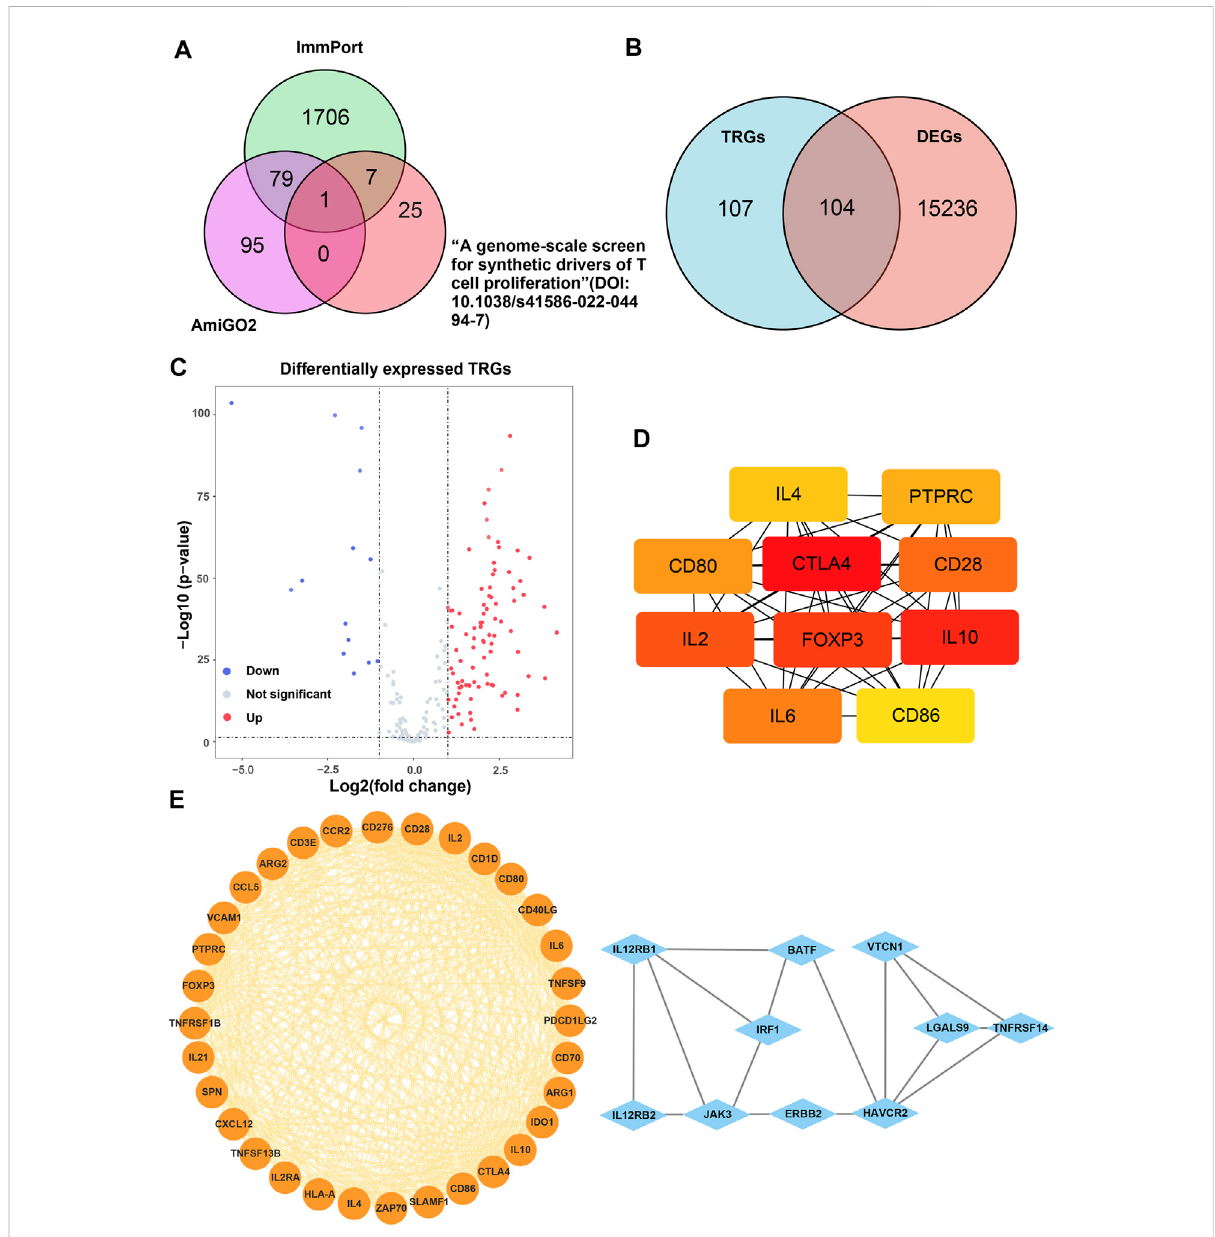
FIGURE 2 Analysis of the differentially expressed TRGs. (A) The Venn diagram depicting intersecting genes in the newly found TRGs and different databases; (B) the Venn diagram depicting intersecting genes in TRGs and DEGs; (C) the volcano plot of differentially expressed TRGs; (D) the interconnection of 10 hub differentially expressed TRGs, darker color represented higher scores; (E) the visualized PPI network of differentially expressed TRGs obtained by using “ MCODE ” plugin of